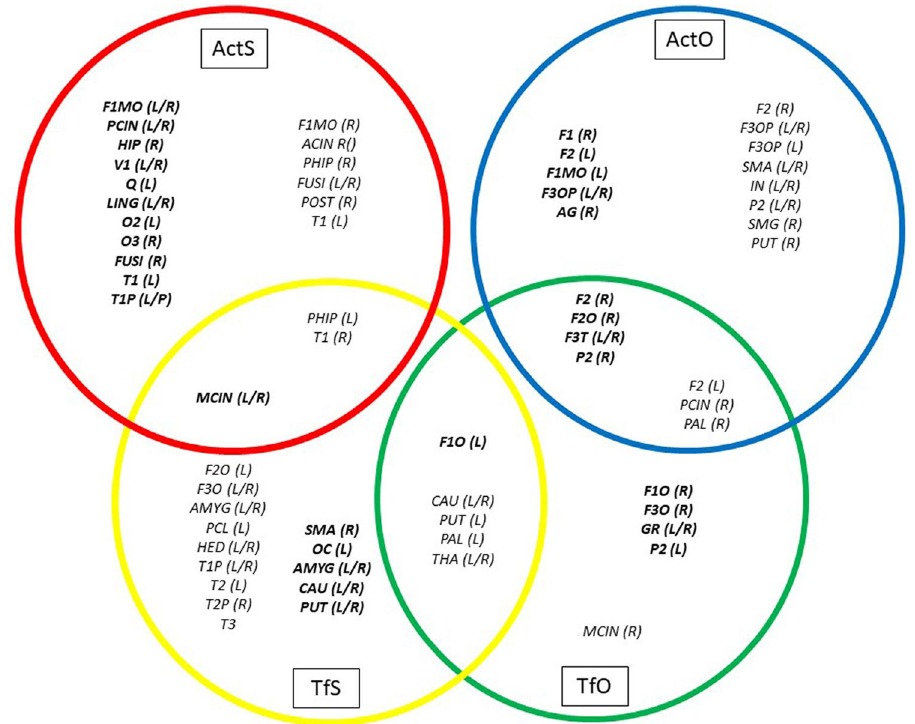
Figure 10. Central nodes in the α-hierarchical level of the multiplex network. The coloured circles are associated to the rules at the α-hierarchical level: red = ActS; orange = Tfs; blue = ActO; green = TfO, and in each circle the brain regions acting as local central nodes are reported. The intermediate multiplex central nodes are in the intersections. In bold are the in-strength central nodes. Notice that: ( a ) the basal ganglia regions are shared by the TfS and TfO rules; ( b ) the fronto-parietal cortex falls within the AcsO and TfO rules; ( c ) a sparse number of brain regions covering the middle cingulum, the parahippocampus and the superior temporal gyrus, are found in the ActS and TfS rules.